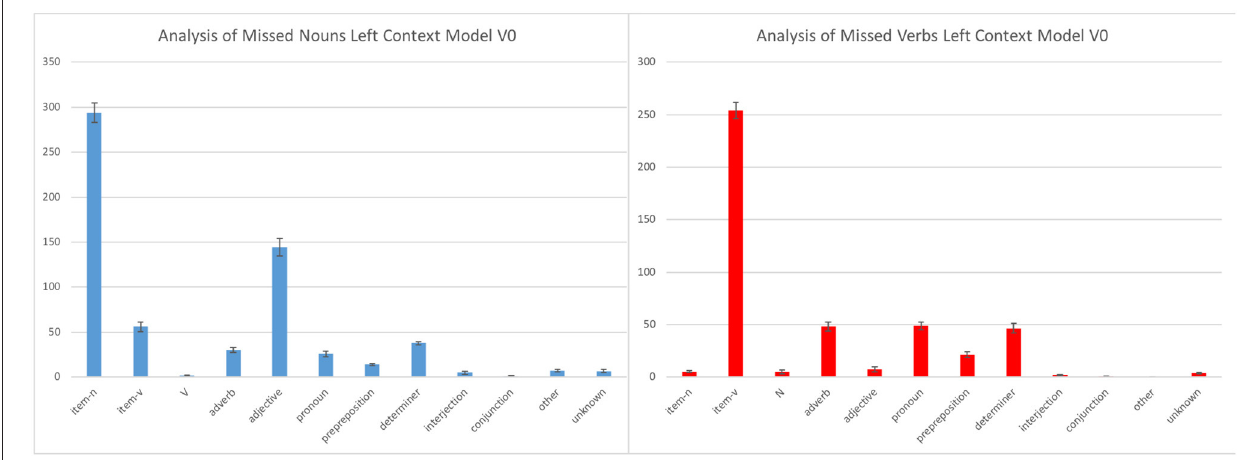
FIGURE 4 | Misses of the left context model with the smallest vocabulary